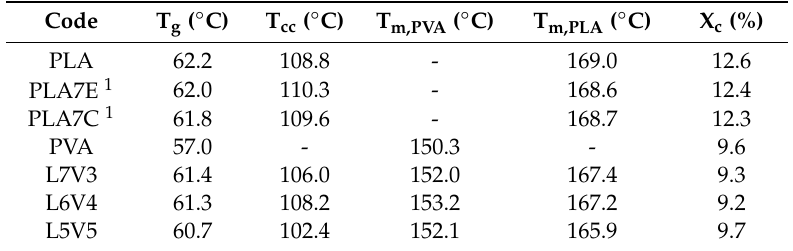
Table 2. Thermal data obtained from the second scanning DSC thermograms.